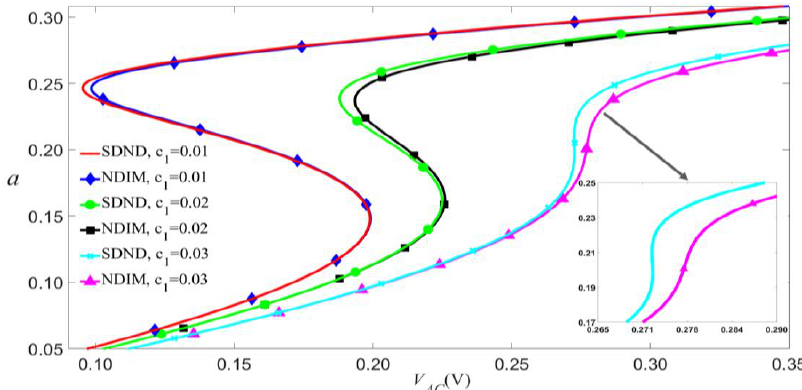
Figure 12. Amplitude of the response as a function of the load’s amplitude of primary resonance for V DC = 4 V, P 0 = 0.01 N, and σ = 0.05 given several damping parameters. It can be seen from Equation (9) that the coefficient C 2 in the cubic nonlinear damping term is worthy of particular attention among the three damping terms. From Equation (5), we have